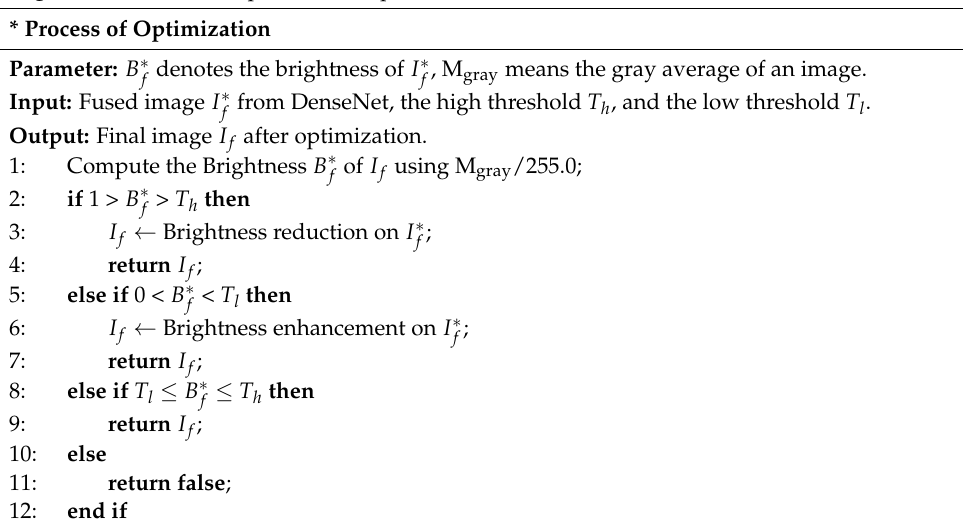
Algorithm 2: The description of the